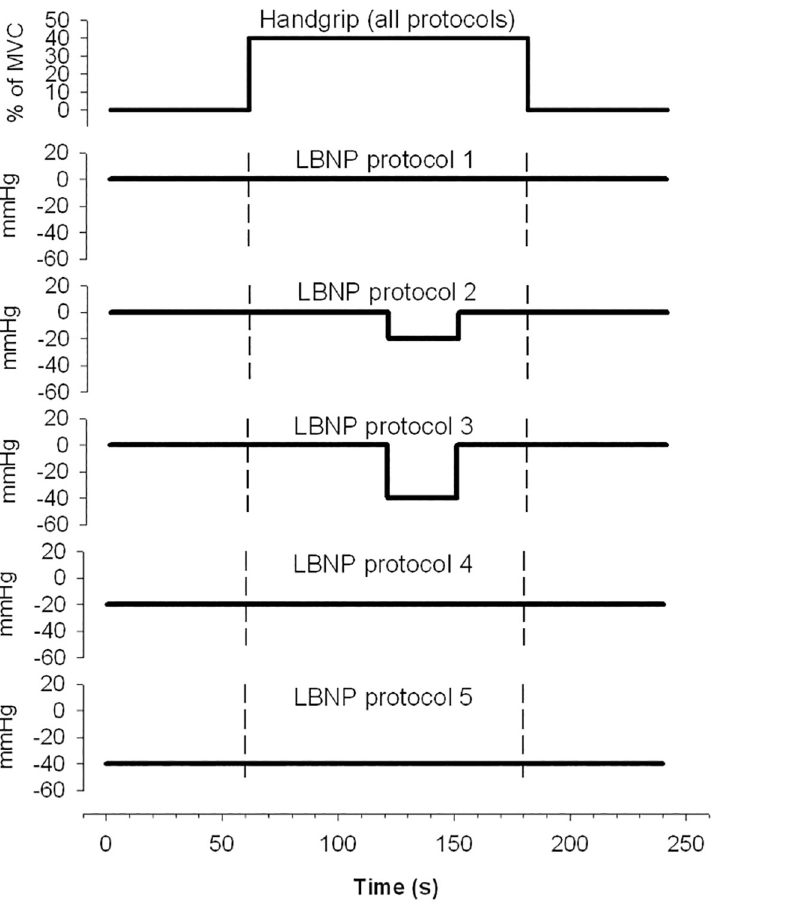
Fig 1. Handgrip and application of LBNP during the different